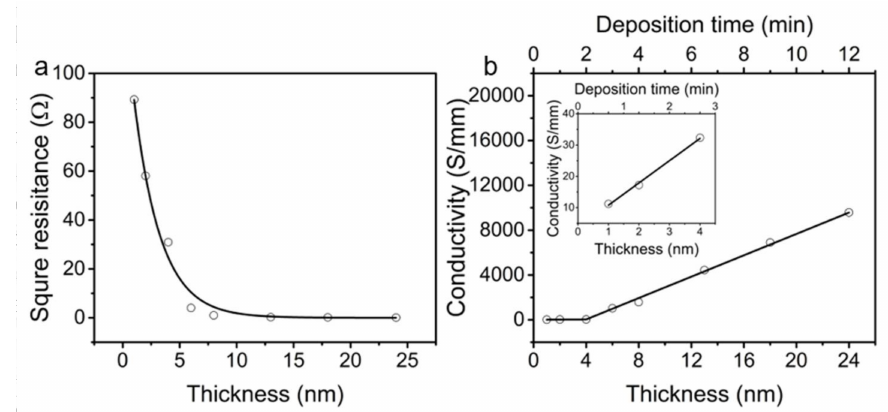
Figure 2. ( a ) The square resistance of the Cu t -CNTS as a function of Cu thickness. ( b ) The conductivity of the Cu t -CNTS as a function of deposition time and thickness of Cu. The inset showed conductance of Cu t -CNTS as a function of deposition time and thickness of Cu for deposition time shorter than three